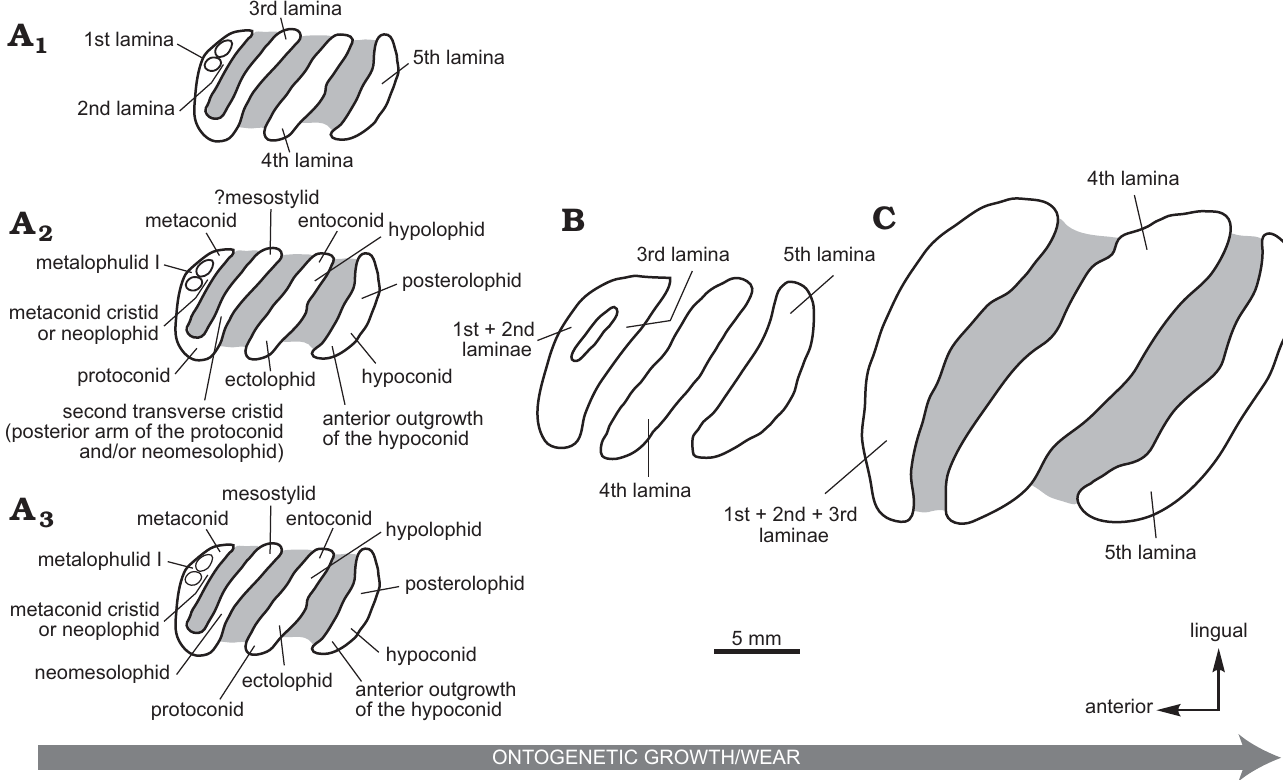
Fig. 4. Explanatory drawings of occlusal morphologies of lower molars at three ontogenetic stages in Phoberomys . A . Pentalophodont pattern in a juvenile specimen: MACN-Pv 2645, right m1 or 2 (occlusal surface) of Phoberomys burmeisteri ; the laminae (A 1 ), homology hypothesis 1 (A 2 ), and homology hypothesis 2 (A 3 ). B .Tetralophodont pattern in a juvenile specimen: MACN-Pv 2645, right m1 or 2 (outline pattern of the dental base) of P. burmeisteri . C . Trilophodont pattern in an adult specimen: MACN-Pv 3475, right m1 or 2 of P. burmeisteri . The direction of the arrow indicates the direction of de- velopment associated with an increase of the ontogenetic growth and dental wear. Note that the position of the fused structures is speculative. Based on Rasia and Candela 2018: fig. (Fig. 5J), Isostylomys (Fig. 5K) or Tetrastylus (Fig. 5L).